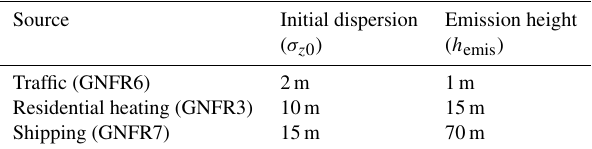
Table 1. Initial dispersion ( σ z 0 ) and emission height ( h emis ) for the three downscaled sources for all primary